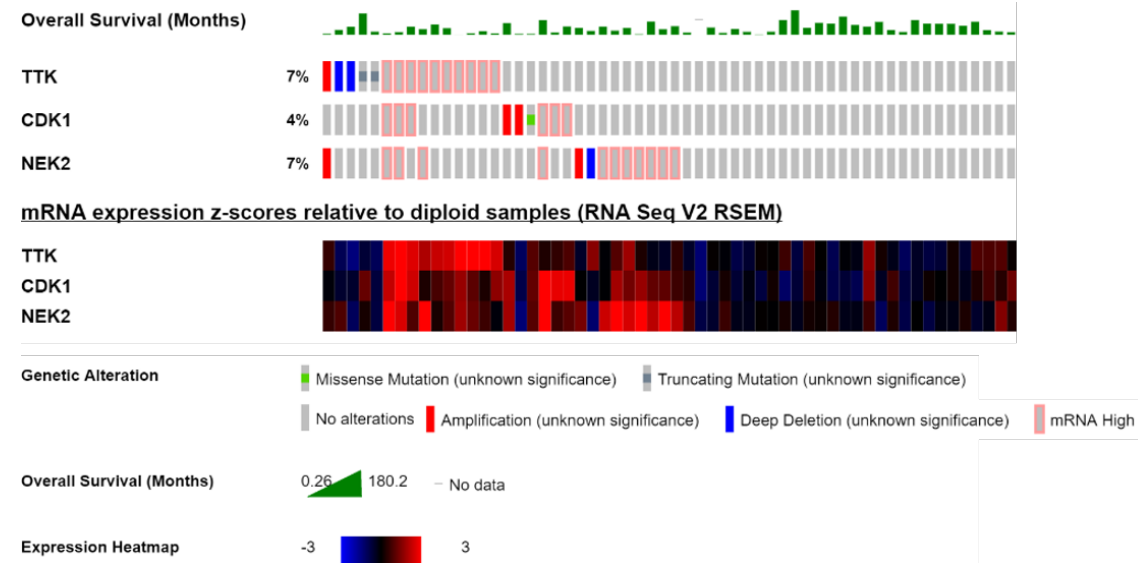
Figure 4. Genetic alteration analysis and OS towards TTK, NEK2, and CDK1 genes through a cBioportal analysis. TTK, NEK2, and CDK1 expressions in ovarian cancer. A bar code plot (OncoPrint) for genetic alterations, mutation status, copy number alterations, mRNA expressions, and OS of TTK, NEK2, and CDK1 genes in ovarian cancer were analyzed using the cBioPortal cancer genomics database.